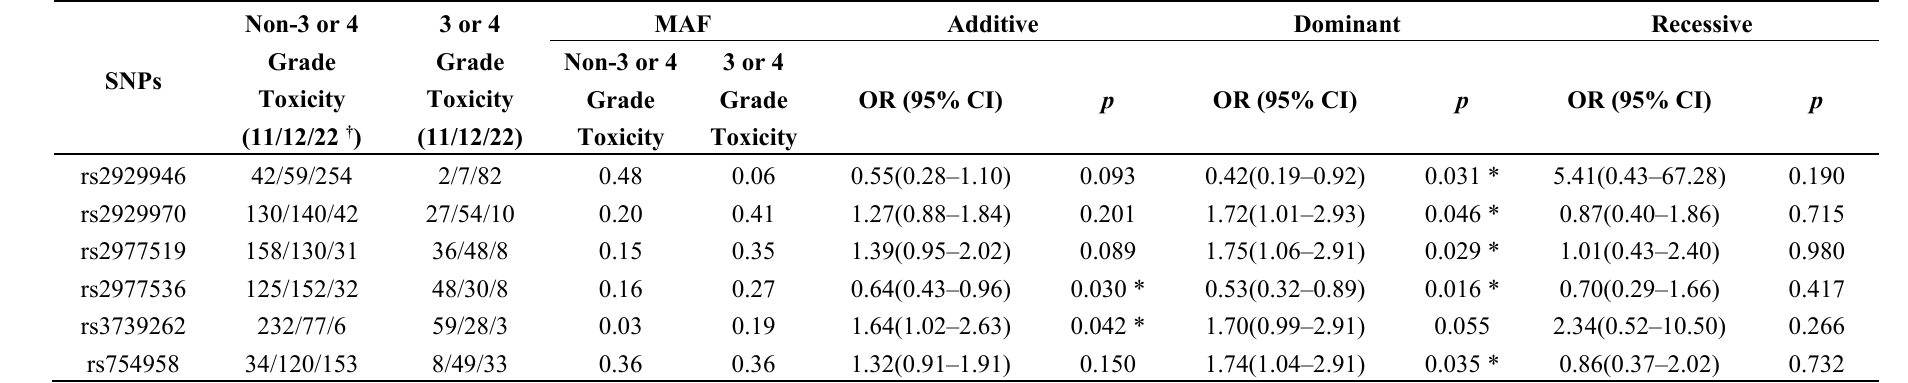
Table 3. Association of rs2929946, rs2929970, rs2977519, rs2977536, rs3739262 and rs754958 with gastrointestinal toxicity in lung cancer